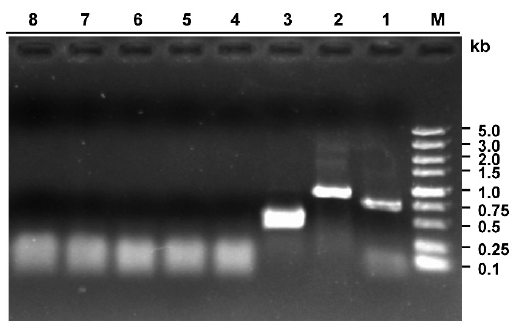
Figure 2. RT-PCR amplification confirming that S. sclerotiorum strain 228 harbored two viruses. Primer pairs were designed based on the sequences of contig 1178 and First_contig 20, representing a novel virus (SsDFV2) and a previously reported virus (BpRV1), respectively. Lane M, DNA weight marker; Lane 1, SsDFV2 specific band in strain 228; Lane 2, BpRV1 (dsRNA1) specific band in strain 228; Lane 3, BpRV1 (dsRNA2) specific band in strain 228; Lanes 4,5, Neither SsDFV2 nor and BpRV1 were detected in strain N36; Lanes 6,7, Neither SsDFV2 nor BpRV1 were detected in strain Ep-1PNA367; Lane 8, ddH 2 O control.